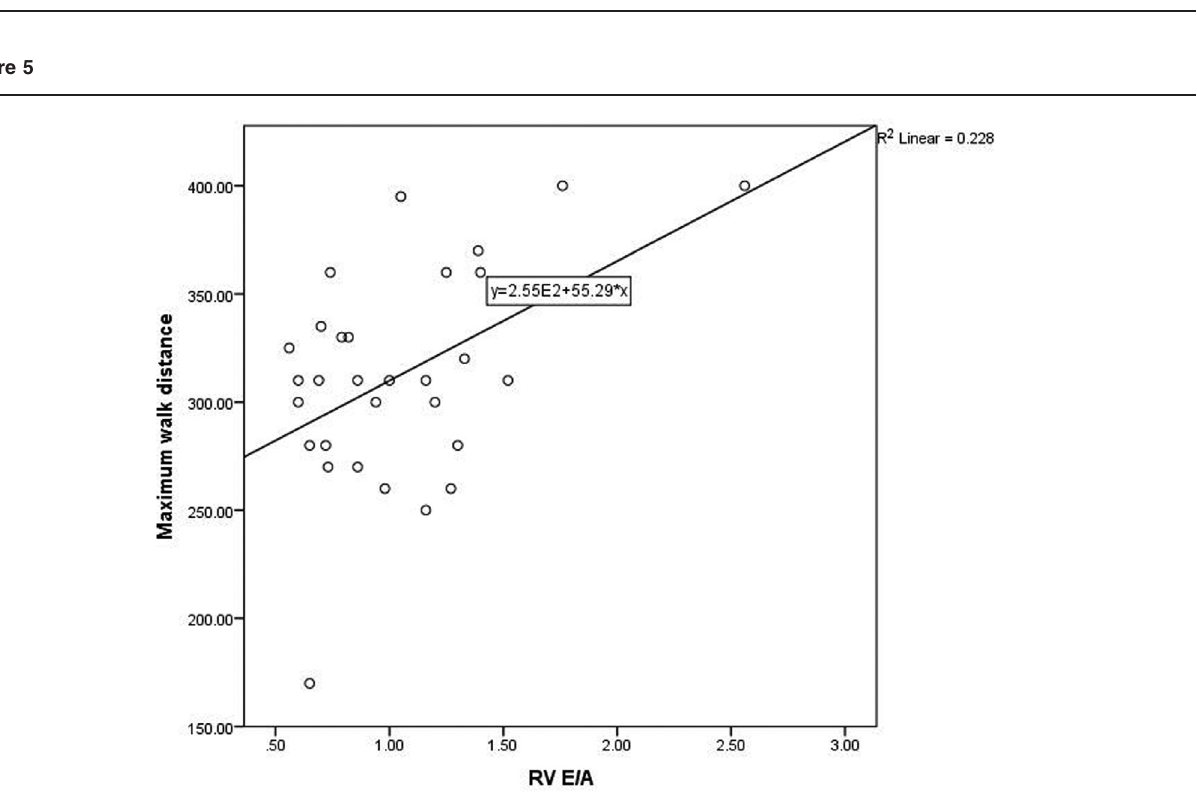
Correlation between 6-min walk distance and transtricuspid E/A in group B. A lower 6-min walk distance is correlated with a lower E/A in patients with severe to very severe COPD. COPD, chronic obstructive pulmonary